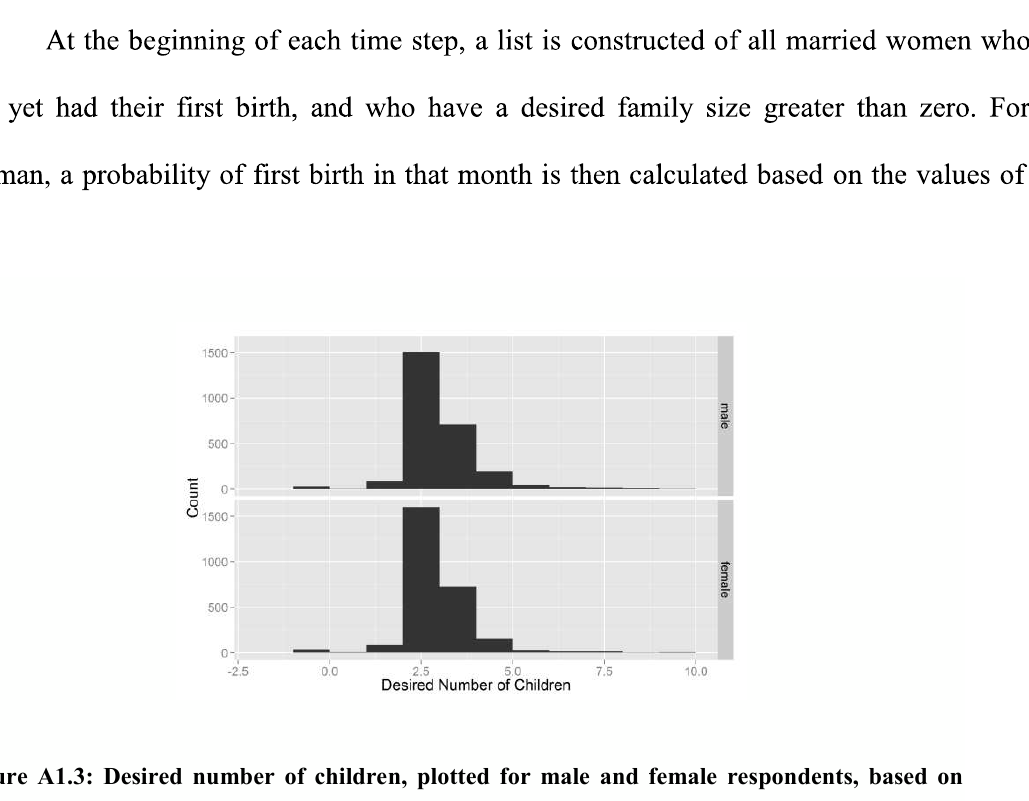
Figure A1.3: Desired number of children, plotted for male and female respondents, based on data from the